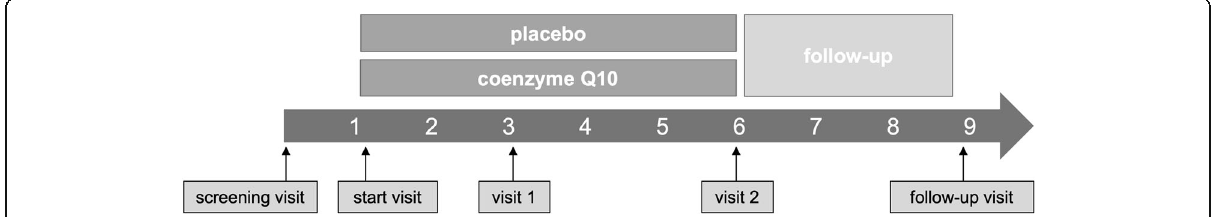
Fig. 2 Overview on the time schedule of this clinical trial. The intermittent phone calls are not shown for better